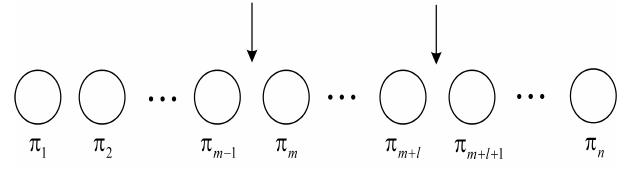
Figure 4. Illustration of Reversion operator.